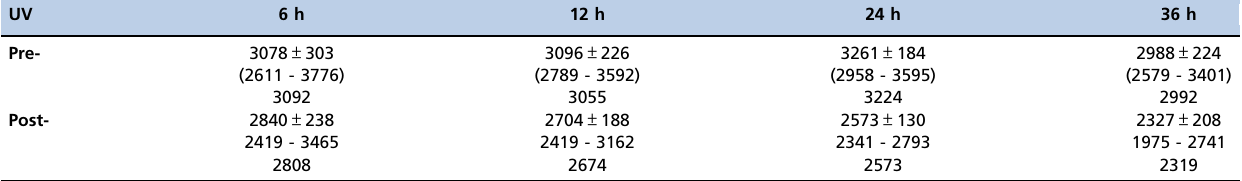
Figure 2 - Radiographic appearance of the bone segments after the demineralization process: before demineralization (a) and after 6 (b), 12 (c), 24 (d) and 36 (e) hours. Differences are not apparent, except for some thinning of the cortex and rarefaction of the medullary cancellous bone. Table 1 - UV (m/s) data (mean ± SD, range, median) before and after demineralization according to demineralization time